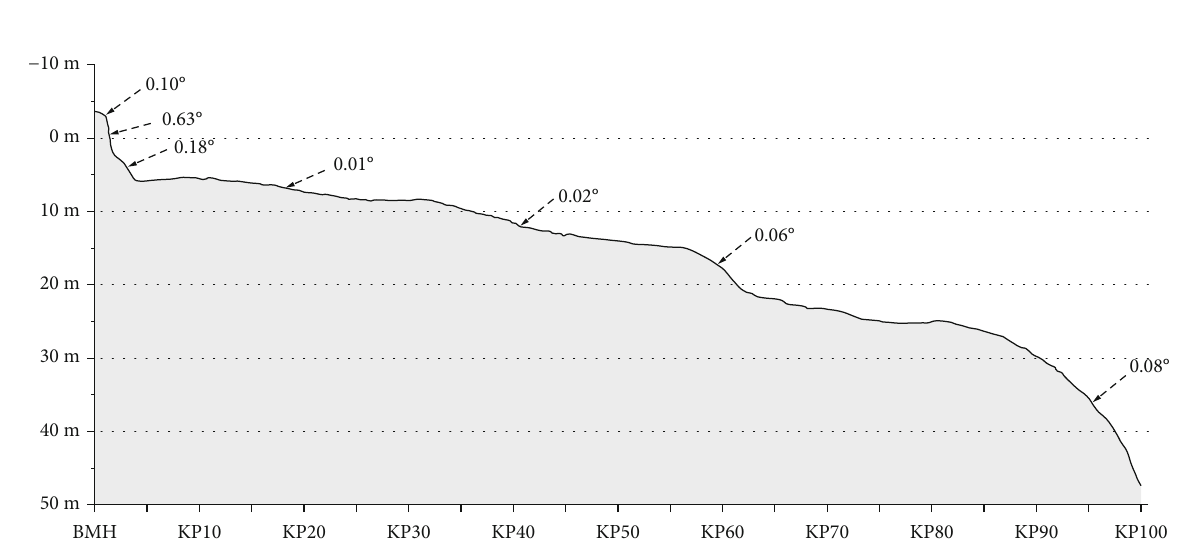
Figure 2: Location of the study area (the fi gure shows the seabed landform of the East China Sea [22]).